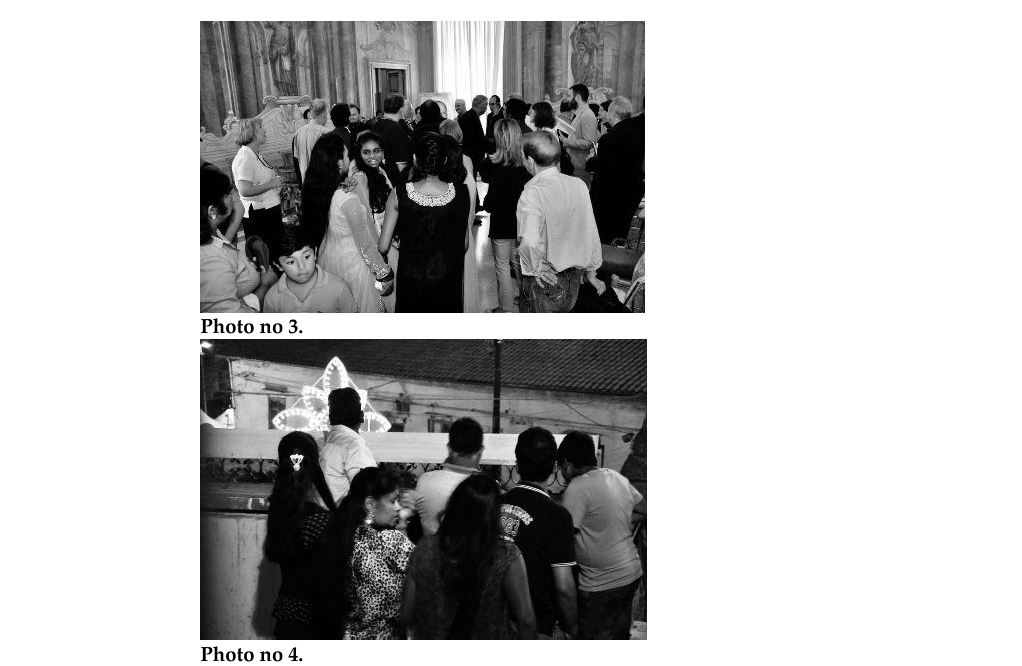
Figure A1. Photographic Appendix. Source: The photos were taken by the author in collaboration with Antonio Ferrante, who has authorised their publication.